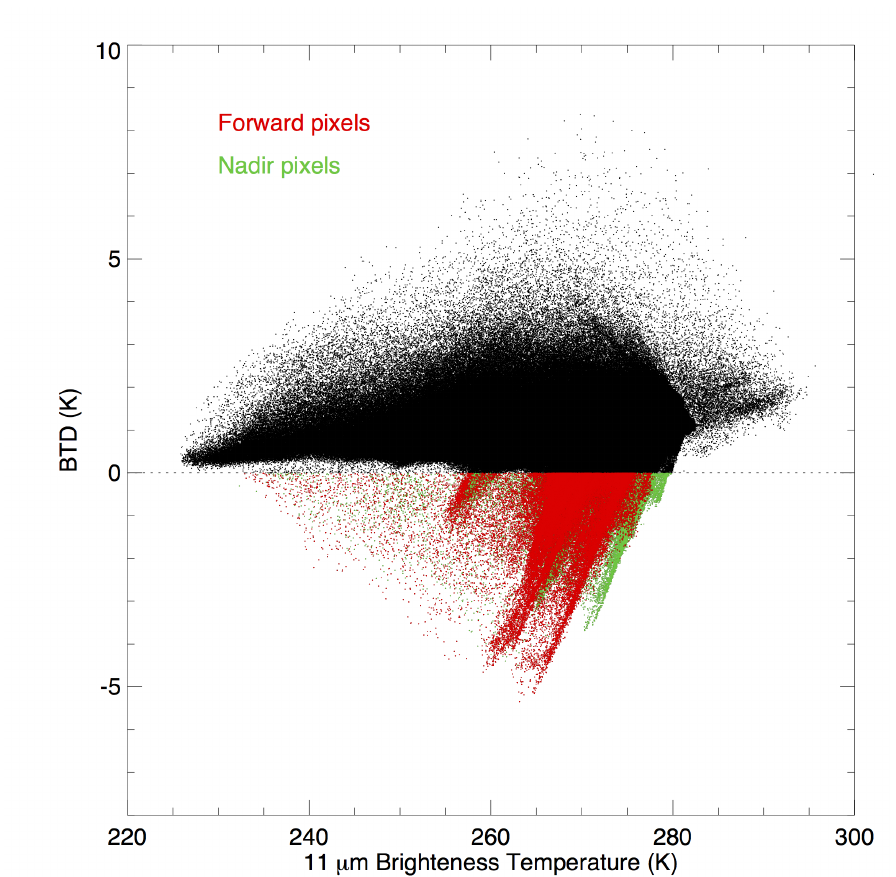
Figure 11. Brightness temperature (11 µ m) vs. BTD plot for the images shown in Figure 9. Note that for the forward view, the forward 11 µ m and 12 µ m data have been used. Pixels with BTD < 0 K are indicated in red (forward) and green